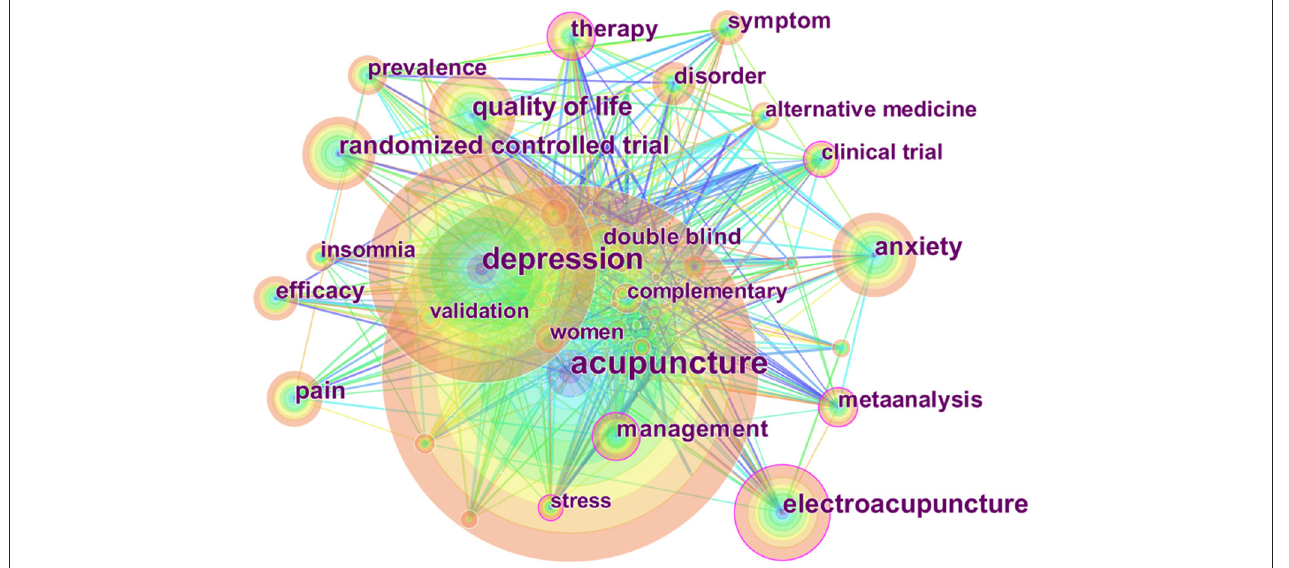
FIGURE 7 | Map of keyword occurrences related to acupuncture for depression from 2011 to